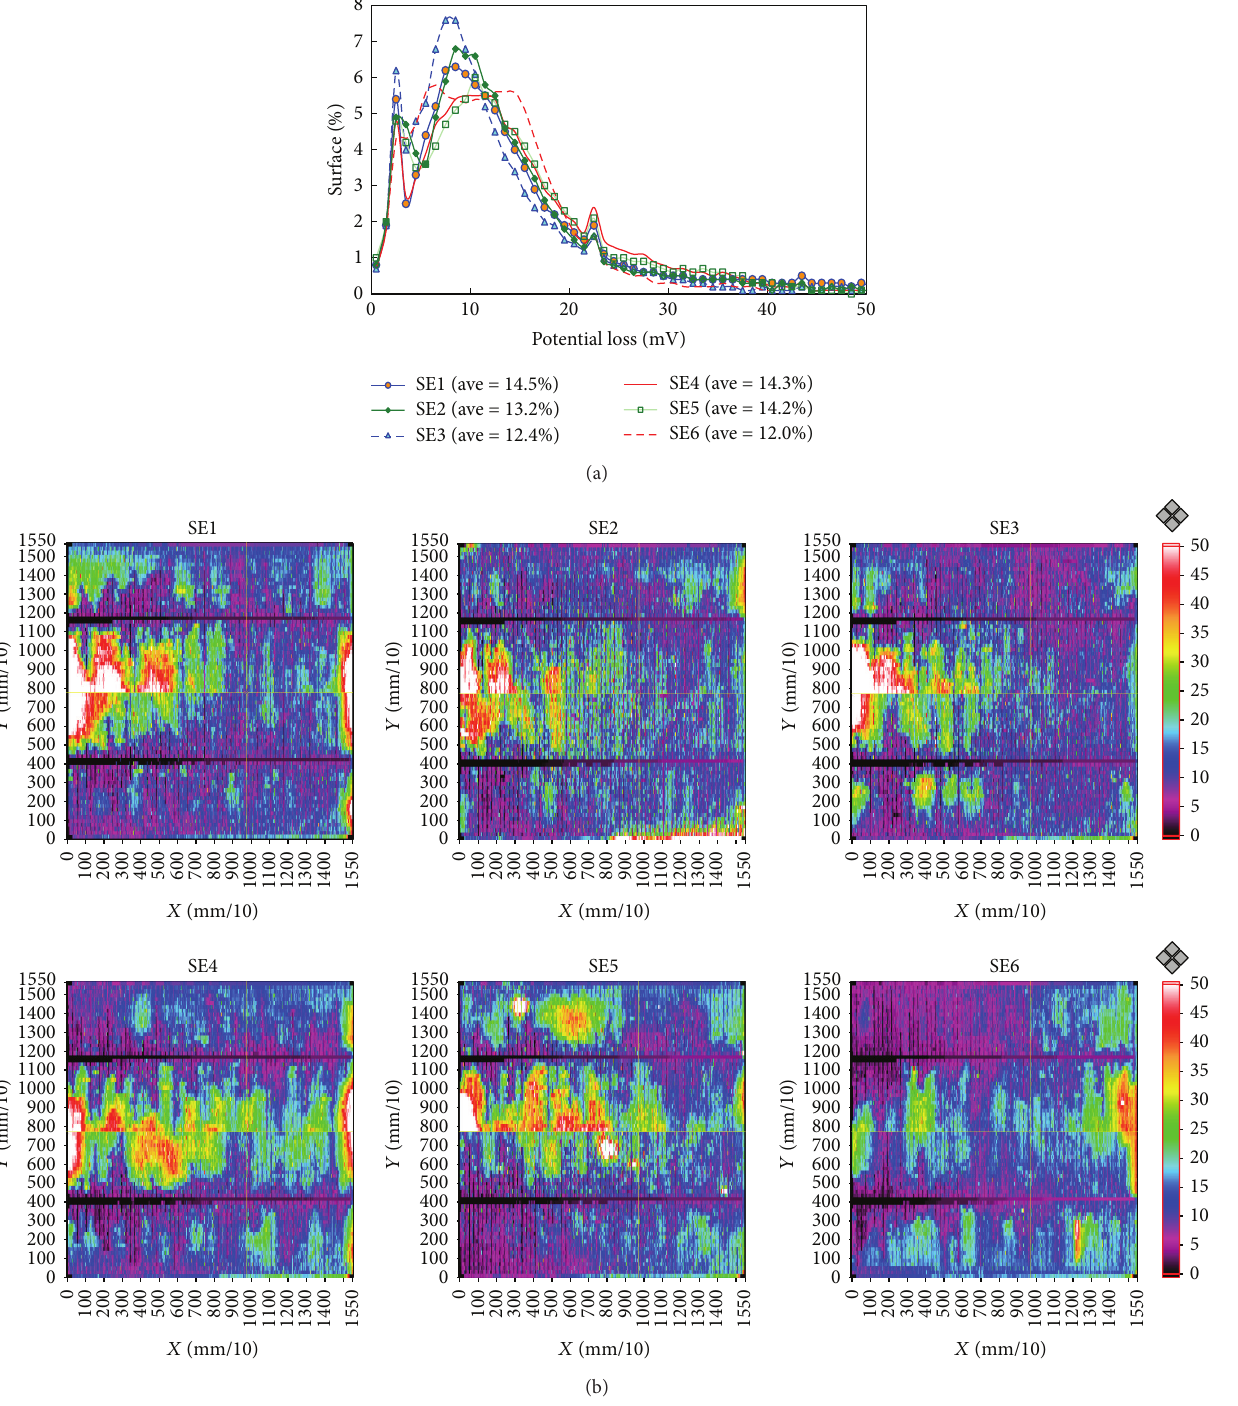
Figure 9: (a) Distribution profile for comparison with potential loss (in mV) of the occupied minority carriers (in %) and average values on the surface of the six SE samples and (b) corresponding real-distribution maps of potential loss profiles. The color chart description is the same as Figure